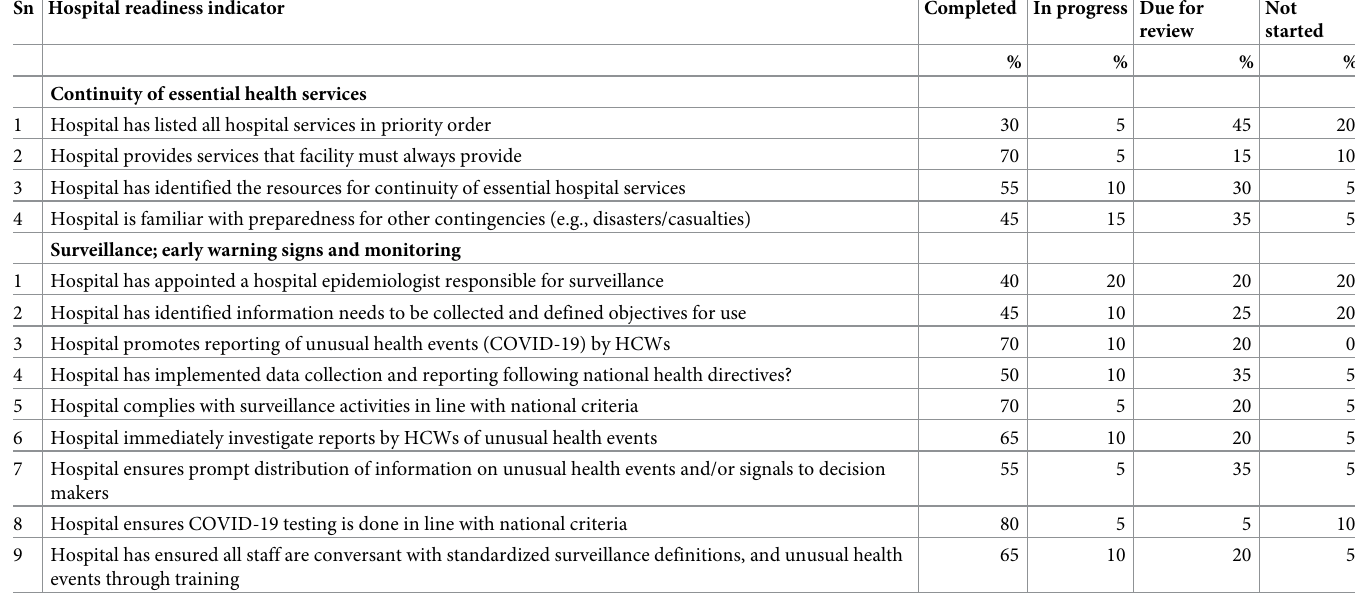
Table 7. Implementation of continuity of essential health services, and surveillance, early warning signs and monitoring readiness indicators among 20 hospitals in